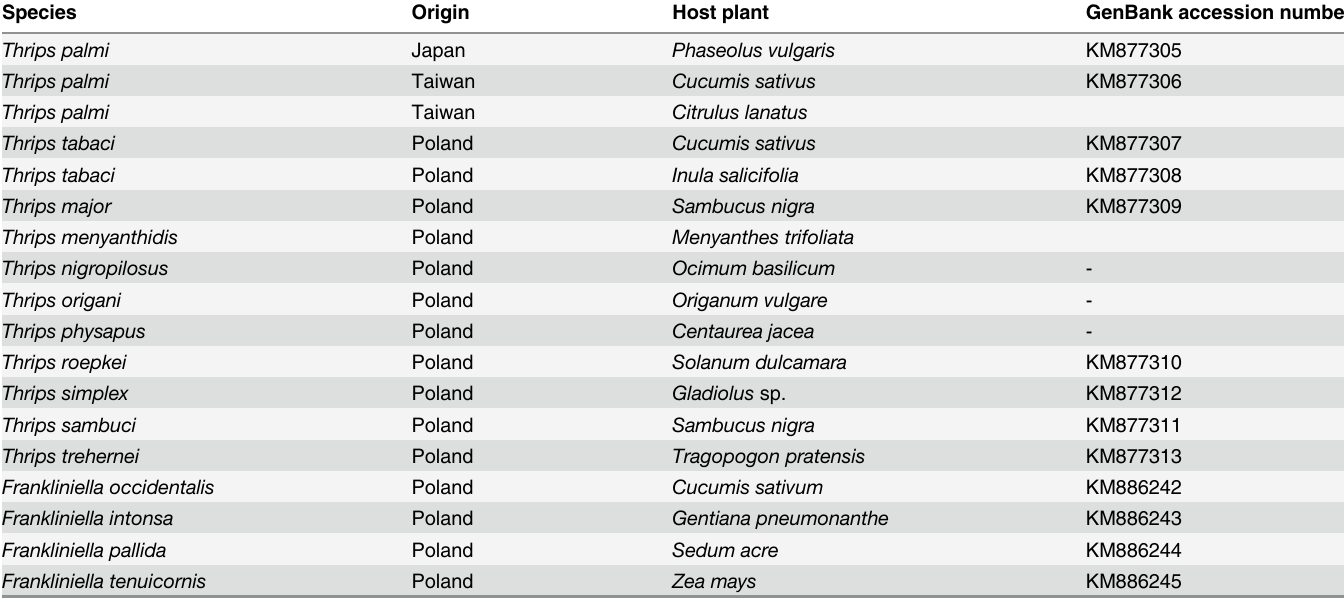
Table 1. Thrips populations used in this